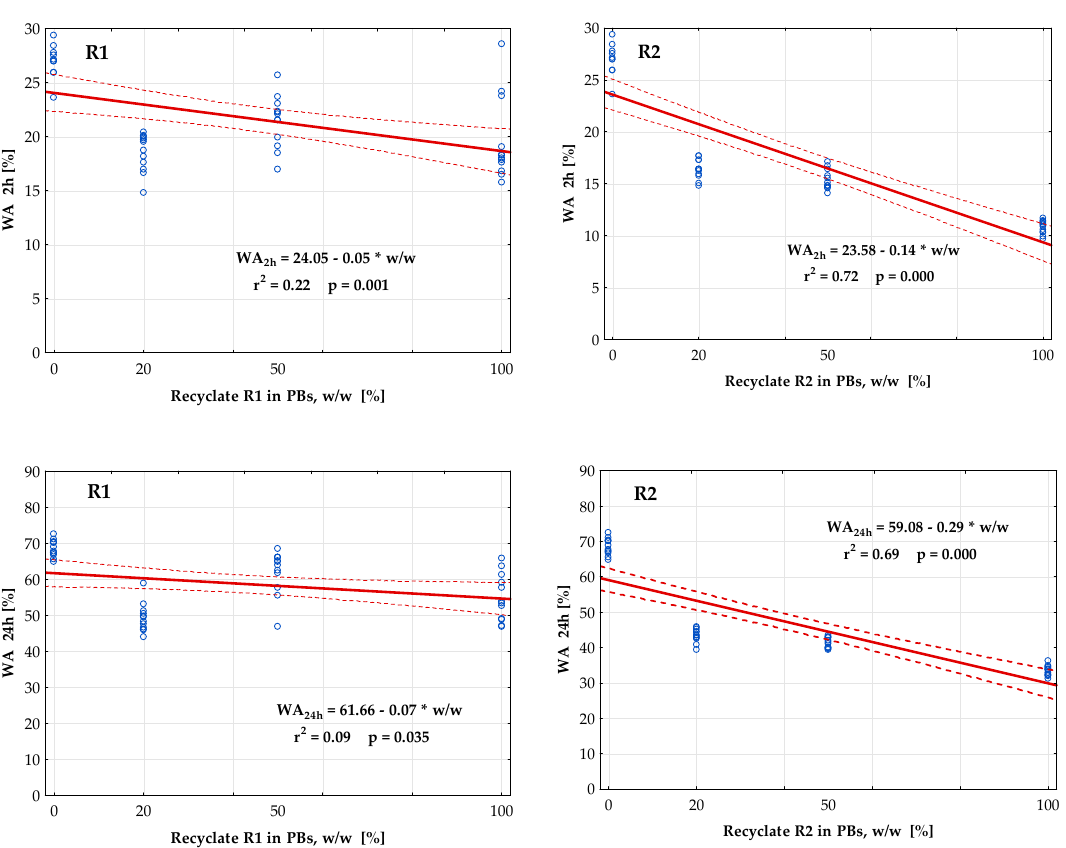
Figure 5. Water absorption (WA) after 2 and 24 h of PBs containing different types (R1 or R2) and amounts of wood recyclates.